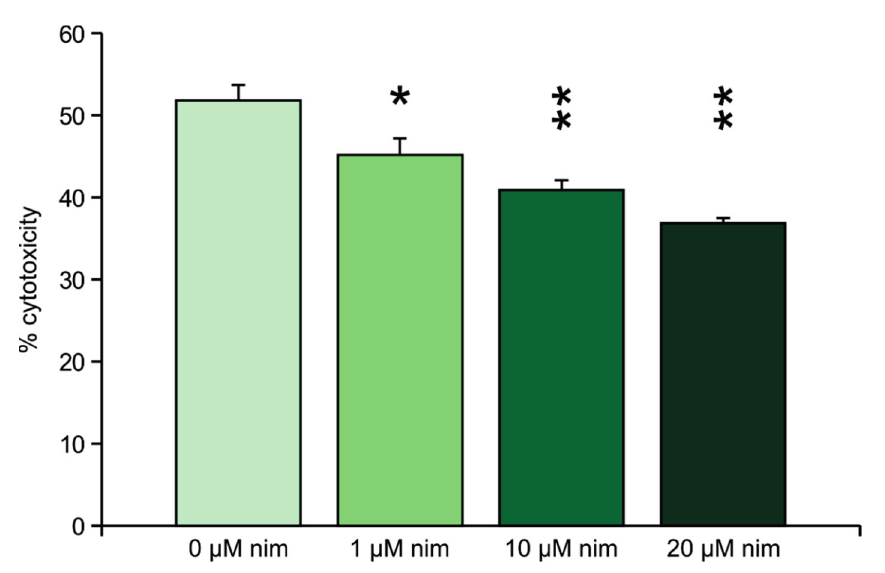
Figure 3. LDH measurement after mechanical stress. Values are given as the mean ± SD (error bars) of one representative out of at least three biologically independent experiments. Nim: nimodipine; single asterisk: p ≤ 0.05 compared to non-treated cells; double asterisk: p ≤ 0.005 compared to non-treated